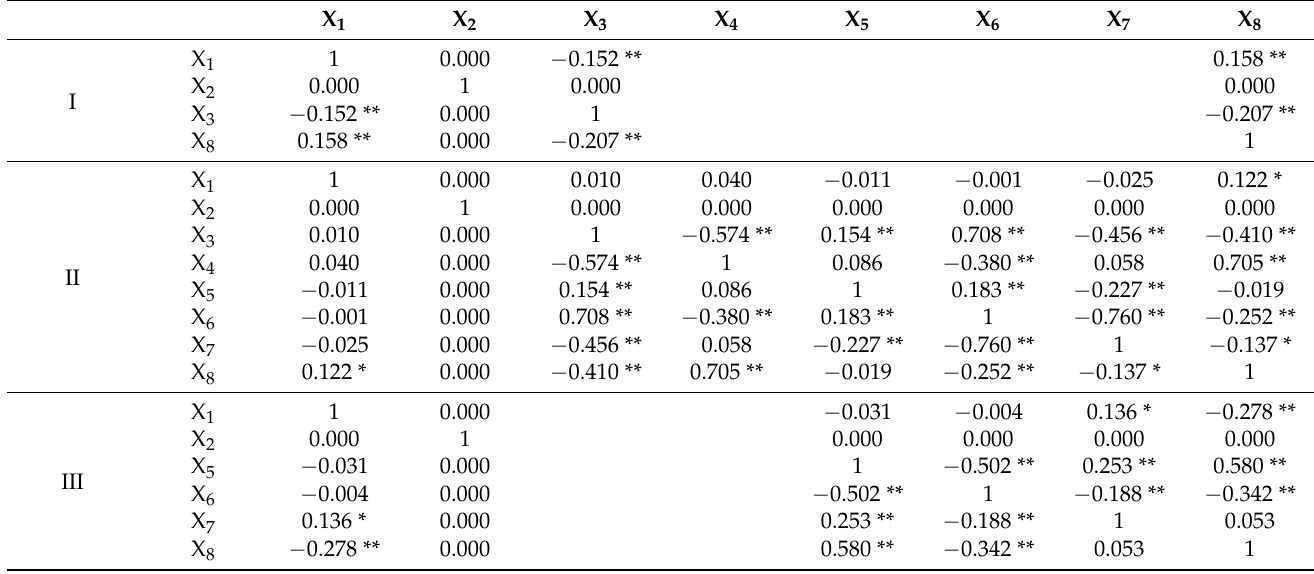
Table 3. Collinearity